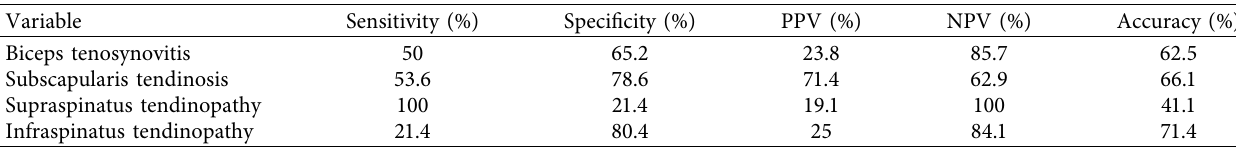
Table 3: Comparison of physical examination versus ultrasound in detecting shoulder pathologies in HD patients ( n � 56 shoulders).